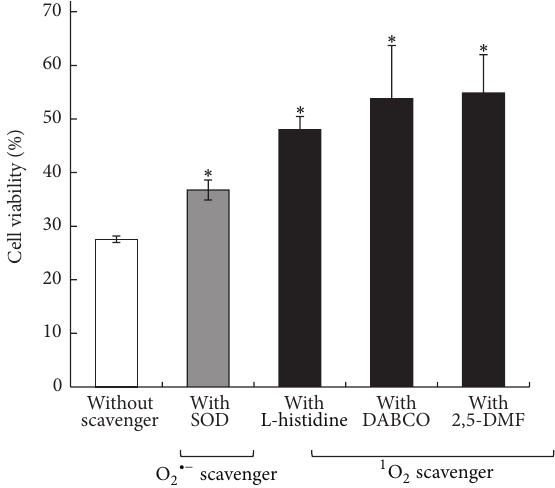
Figure 4: Effect of ROS scavengers on photodynamic effect by C 60 /HP- 𝛽 -CyD nanoparticles on HeLa cells. Each value represents the mean ± S.E. of 5 experiments. ∗ 𝑃 < 0.05 versus without ROS scavenger.